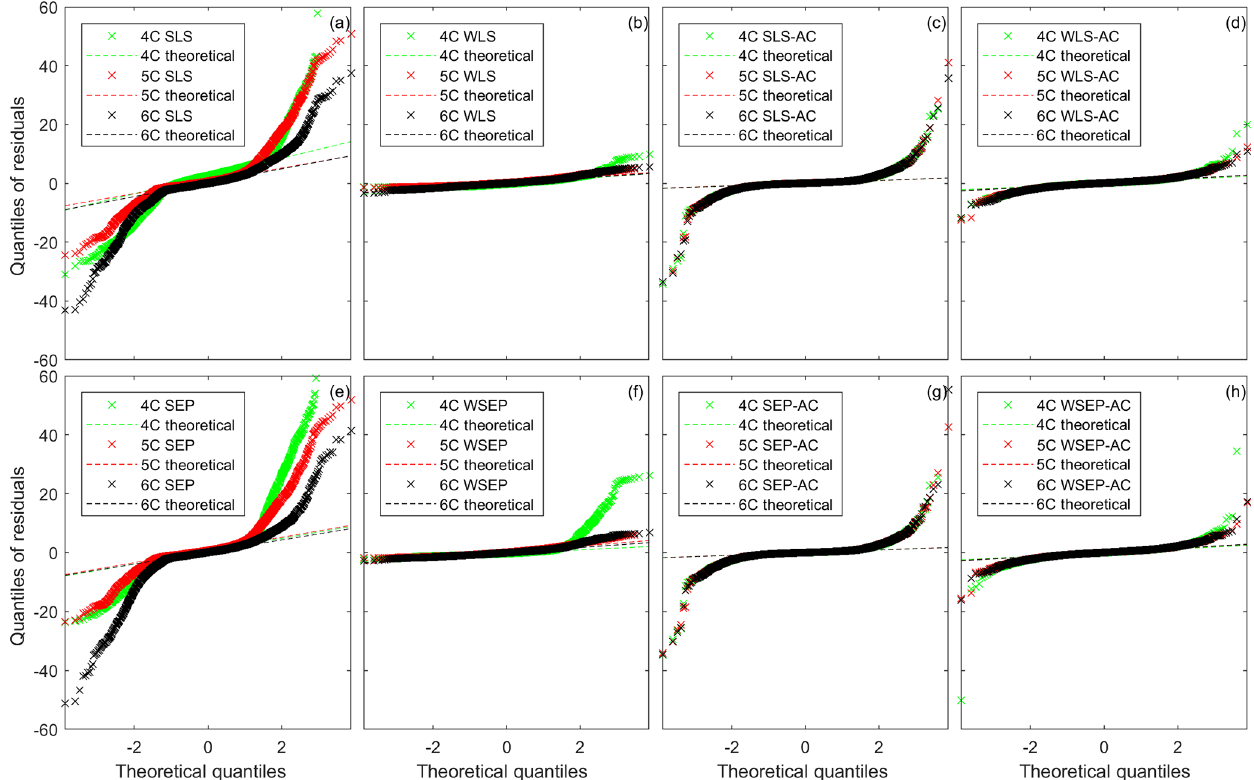
Figure 4. Residual quantile–quantile (Q–Q) plots of the best realization (among multiple MCMC realizations) for the three soil respiration models and eight data